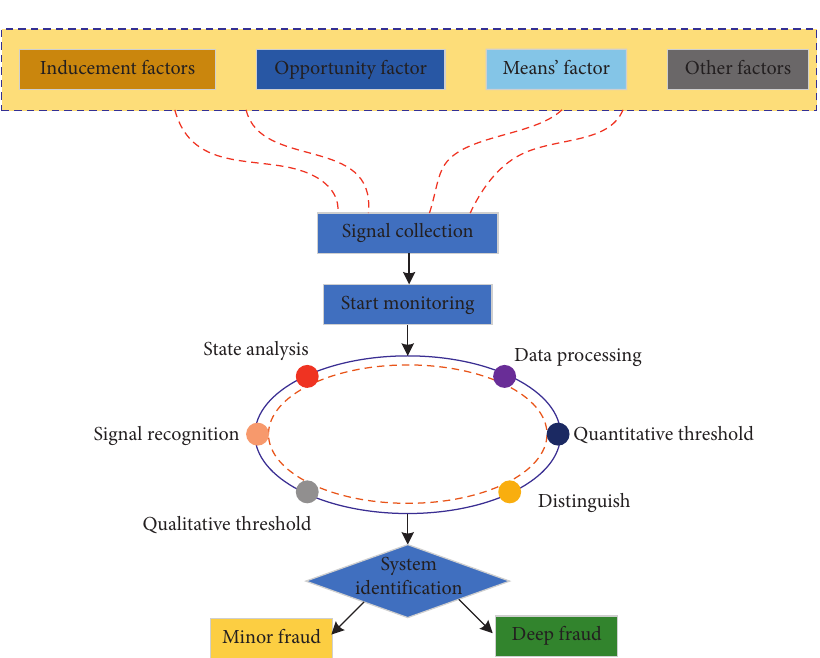
Figure 4: The process of the accounting fraud identification model.